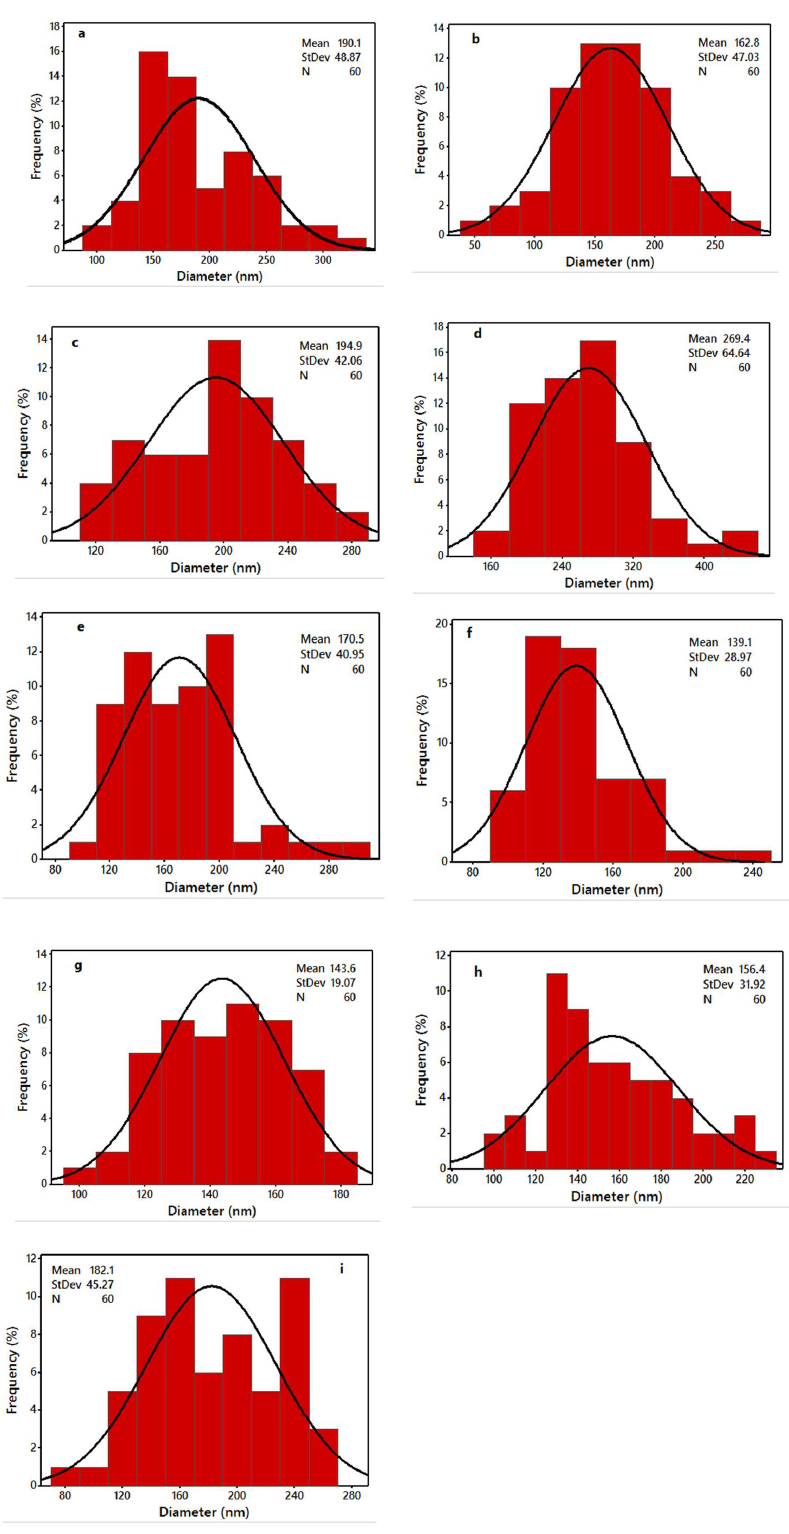
Figure 6. Diameter distribution histograms of W S CHT-PVA nanofibres ( a – i ), produced according to the experimental design shown in Table 4.